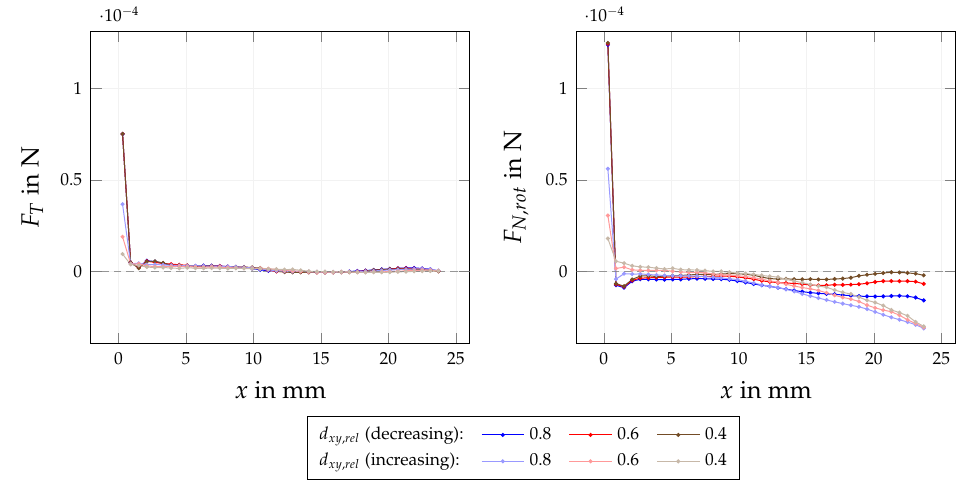
Figure 29. Distribution of tangential forces F t and rotation-induced normal forces F n , rot in central PM fragment row with increasing and decreasing substrate coverage beginning from or ending with different relative fragment sizes d xy , rel